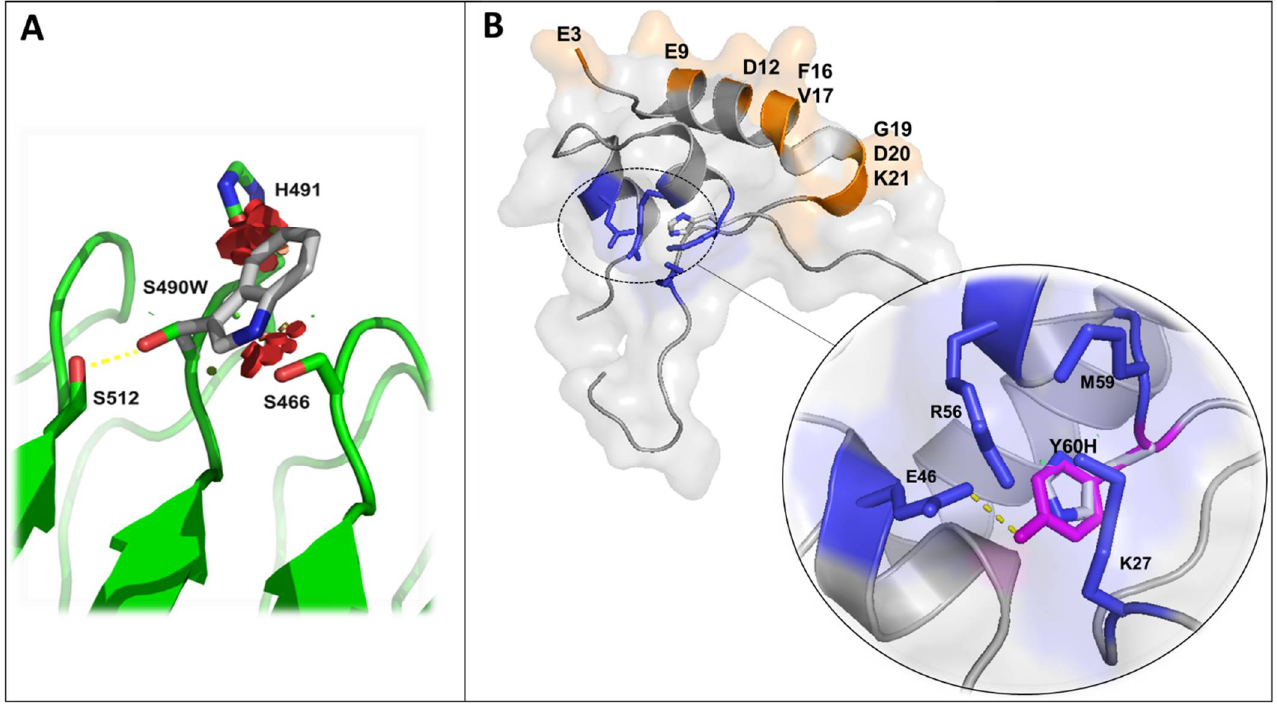
Figure 3. Molecular models of ALS and IGF1 variants. In silico substitutions were performed using PyMol Mutagenesis Wizard and side-chain rotamers were chosen to avoid steric clashes with the rest of the residues. Selected residues are represented in stick and labeled. ( A ) p.S490W-ALS variant. The tryptophan side chain (gray) is displayed as an overlay of the WT side chain (green). Loss of hydrogen bond with S512 and steric clashes (depicted as red disks) are predicted after S490W mutation, possibly leading to overall destabilizing effects. ( B ) Cartoon representation of p.Y108H-IGF1 variant structure (equivalent to p.Y60H in the mature peptide). Y60 (showed in magenta) is an identified residue that interacts with IGF1R. The hydroxyl group of Y60 forms a hydrogen bond (dotted yellow lines) with E46 that is lost after tyrosine for histidine substitution (gray residue). Key residues involved in IGFBP-3 interaction (showed in orange) are located on the surface of IGF1 far from the p.Y60H change.